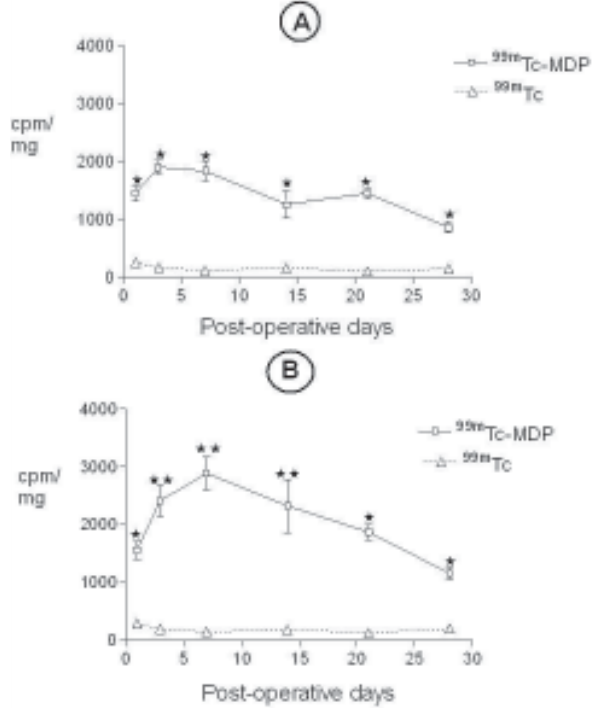
FIGURE 5- Uptake of 99m Tc-MDP and Na 99m TcO in right tibiae of rats. The tracers ( ca. 500 µ Ci) were injected i.v. in parallel 4 groups of animals which were sacrificed 2 h